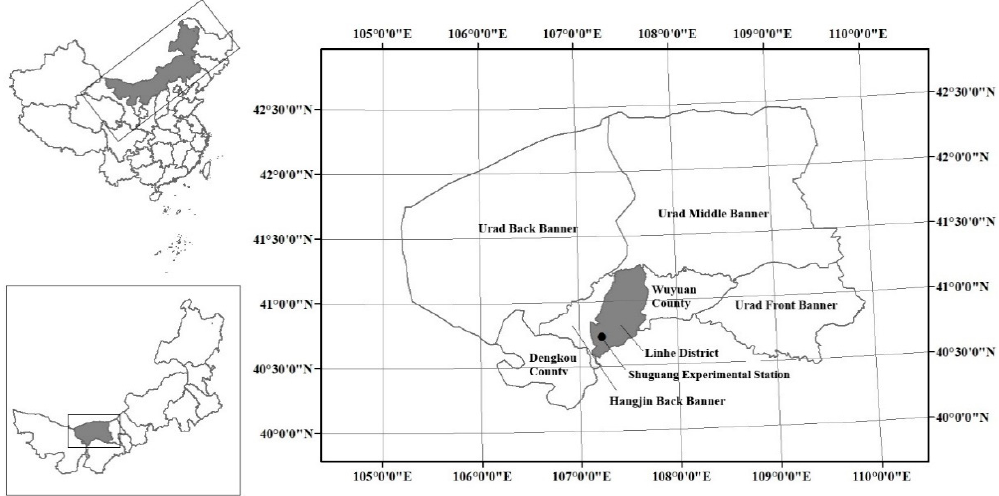
Figure 1. The location of Shuguang Experimental Station in China.